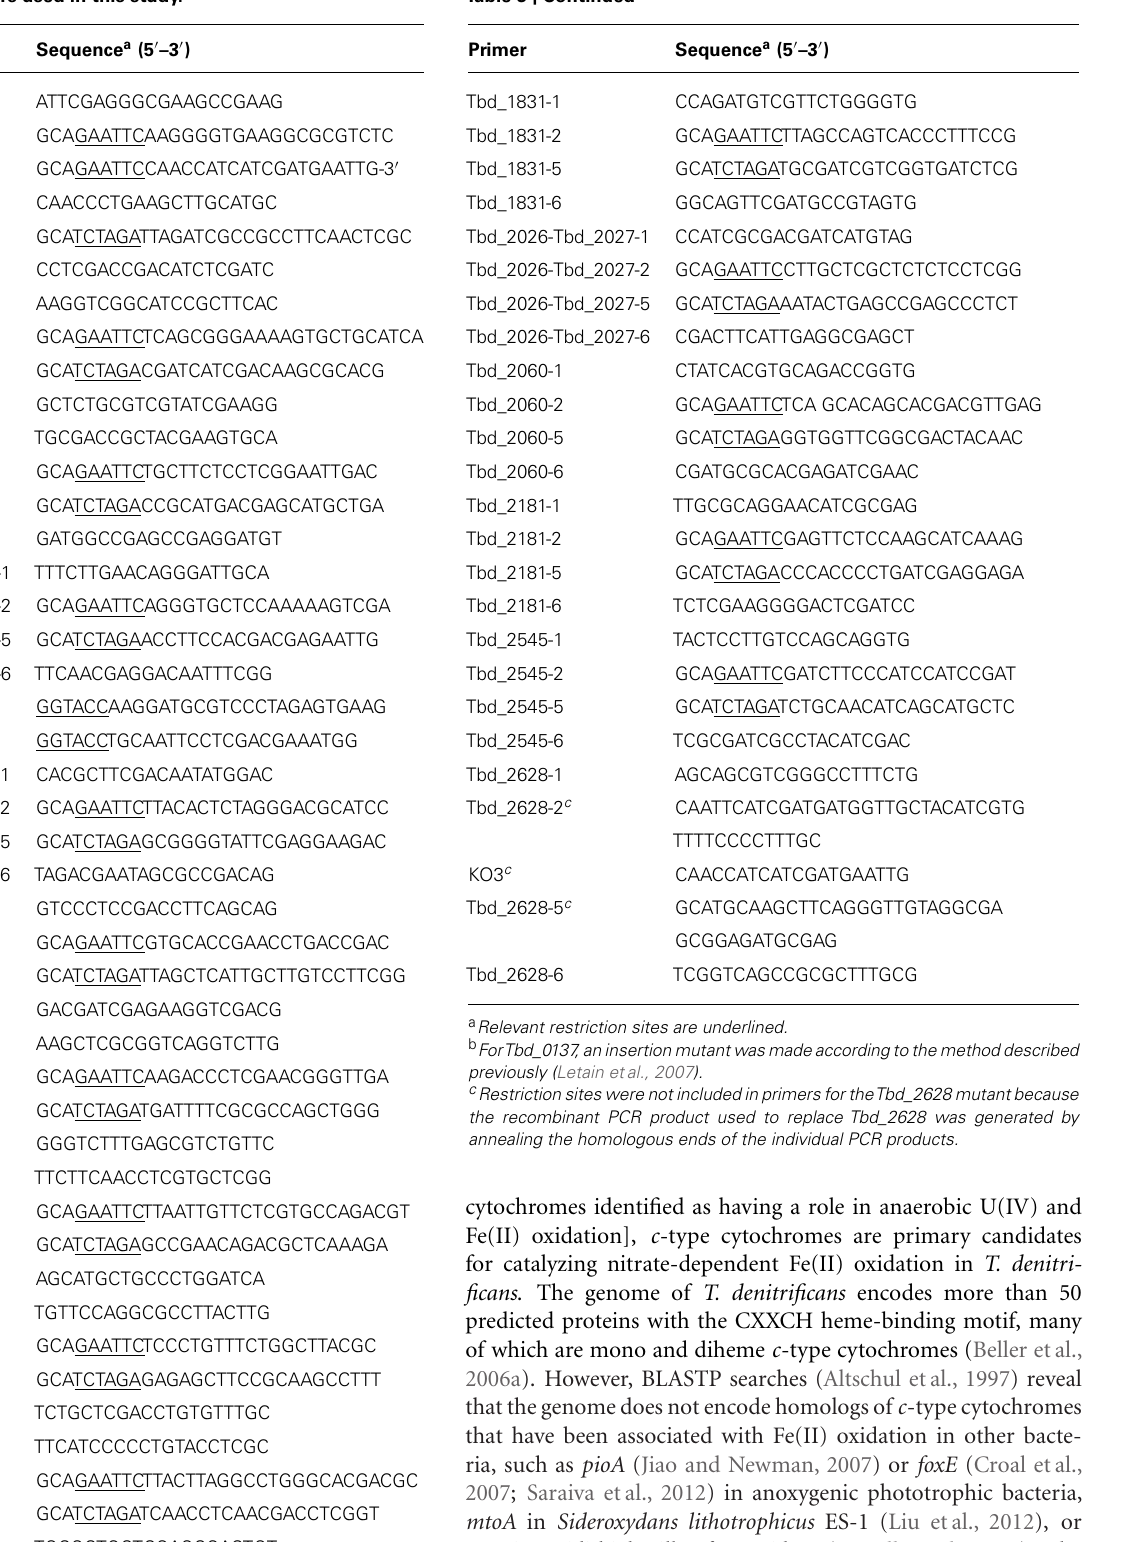
Table 3 | PCR primers used in this